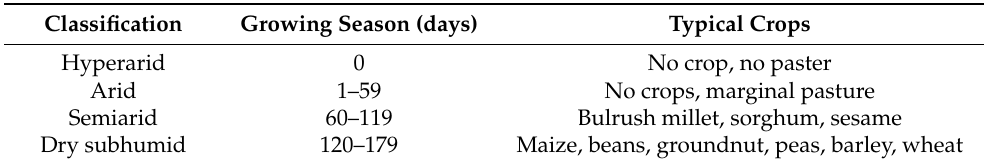
Table 2. Typical rainfed crops grown in